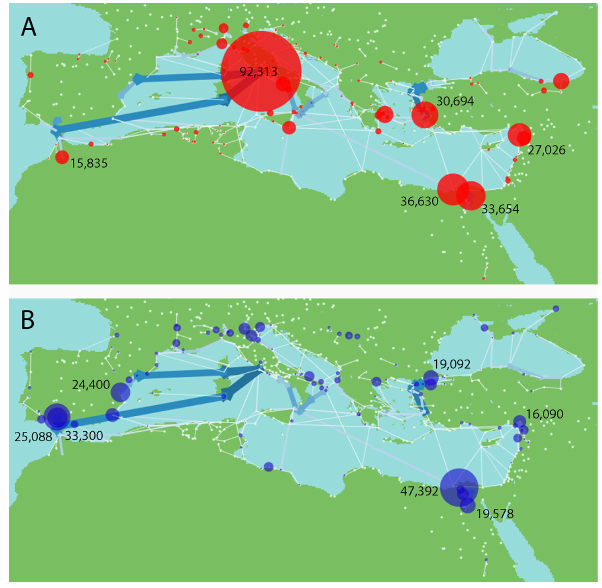
Figure 4. Virtual water imports and exports (tonne grain year − 1 ). The relative amount of VW imported (a) and exported (b) from each node is illustrated by the size of the nodes, whilst the associ- ated numbers show the average VW imported or exported each year expressed in tonnes of grain. The edge colour and thickness indi- cates the relative volume of VW flow between nodes. The largest flows are between eastern and southern Spain and Italy, locally within Egypt, from south-eastern Italy to western Italy and along the Aegean coast of Turkey. Rome is by far the largest importer of VW, followed by Alexandria and Memphis in Egypt, Ephesus on the west coast of Turkey, Antioch in south-eastern Turkey and Corinth in